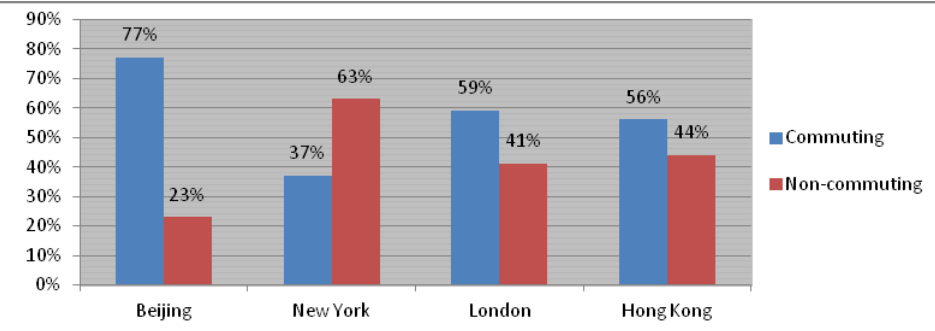
Fig. 10. Trip purposes and travel modes in Beijing (2005) (return trips neglected)(%) Source: Annual Report of Beijing Transport Development (2006)